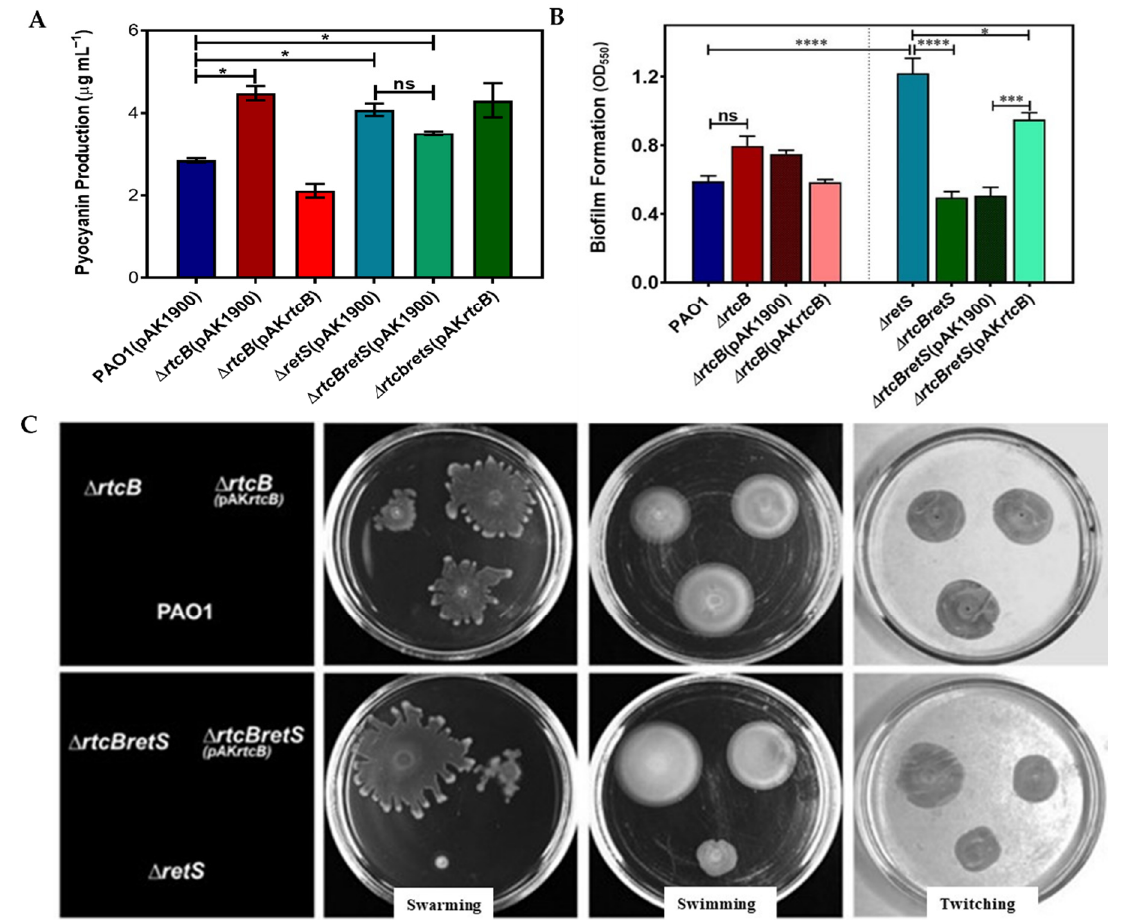
Figure 1. Deletion of rtcB influenced multiple virulence factors of P. aeruginosa . ( A ) Measurement of pyocyanin production in PAO1, PAO1( ∆ rtcB ), PAO1( ∆ retS ), and PAO1( ∆ rtcB ∆ retS ), and the complemented deletion strains with rtcB expression vector. Pyocyanin was produced in significantly higher amounts in PAO1( ∆ rtc B) and PAO1 ( ∆ retS ) compared to PAO1. The complementation of rtcB deletion mutants restored the pyocyanin production. ( B ) Biofilm formation was assayed in a 96-multi-well plate under static conditions. Biofilm formation was significantly higher in PAO1( ∆ retS ) than in PAO1. The PAO1( ∆ rtcB ∆ retS ) strain formed significantly less biofilms compared to PAO1( ∆ retS ). Biofilm formation in the complemented strains returned to the levels of PAO1 and PAO1( ∆ retS ), respectively. ( C ) Motility assays revealed that swarming and swimming motilities of PAO1( ∆ rtcB ) were decreased compared to the wild-type PAO1. Swarming, swimming, and twitching were increased in PAO1( ∆ rtcB ∆ retS ) compared with PAO1( ∆ retS ). Overexpression of rtcB in the rtcB deletion strains reduced the motilities to levels similar to the background. ( A , B ): Data from three independent experiments were analyzed using one-way ANOVA with Dunnette post-hoc test. ( C ): images are representative of three independent experiments. ns, p > 0.05, * p < 0.05, *** p < 0.001, and **** p <